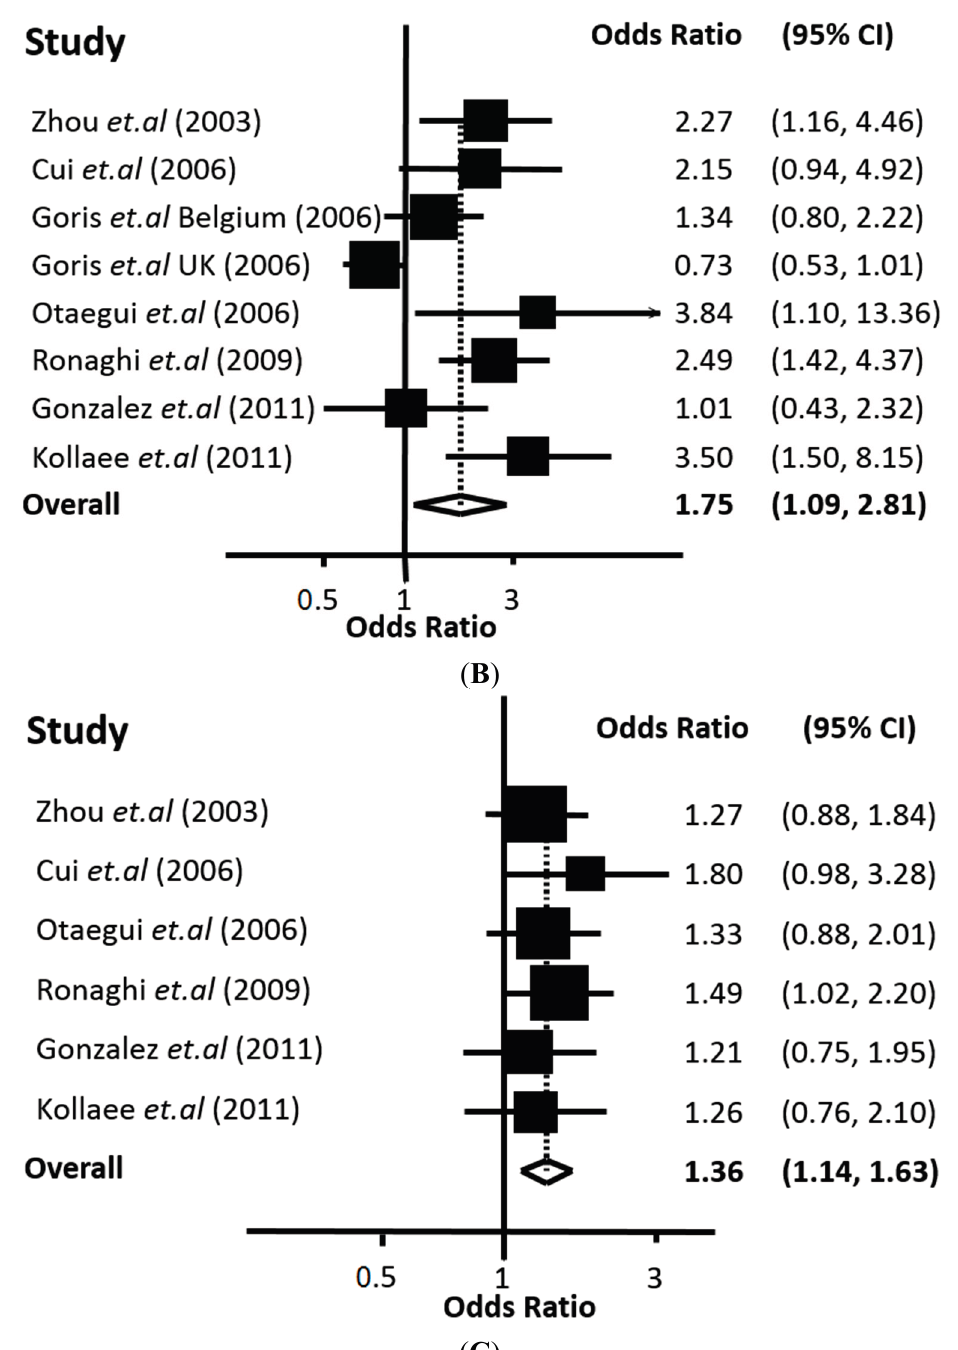
Figure 1. Forest plot of the meta-analysis for the association of the 226 C>T (Ala57Val) polymorphism of the CD24 gene with multiple sclerosis. For each study the estimate of the variance, OR and its respective 95% Confidence Interval (CI) are plotted with a box and a horizontal line, respectively. The dashed vertical lines indicate the overall estimate, whereas the solid ones indicate the null effect (OR = 1). The ORs correspond to ( A ) the allele contrast T vs. C; ( B ) the TT vs. TC + CC contrast and ( C ) the TT + TC vs. CC genotype